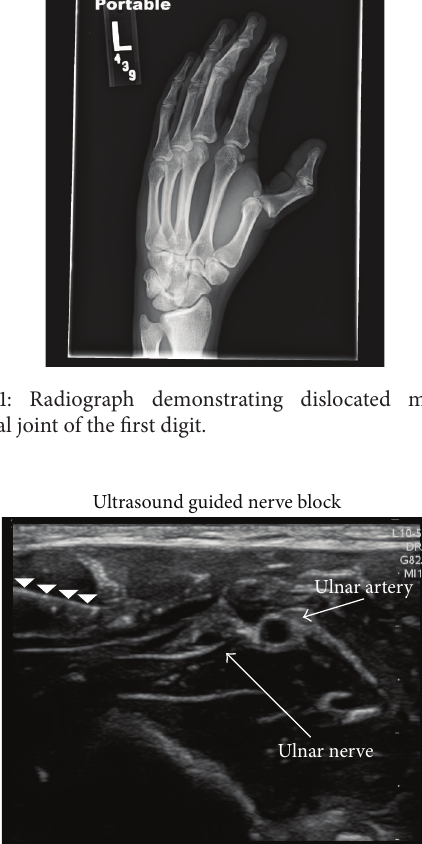
Figure 2: Ultrasound image demonstrating needle and anesthetic solution around the ulnar